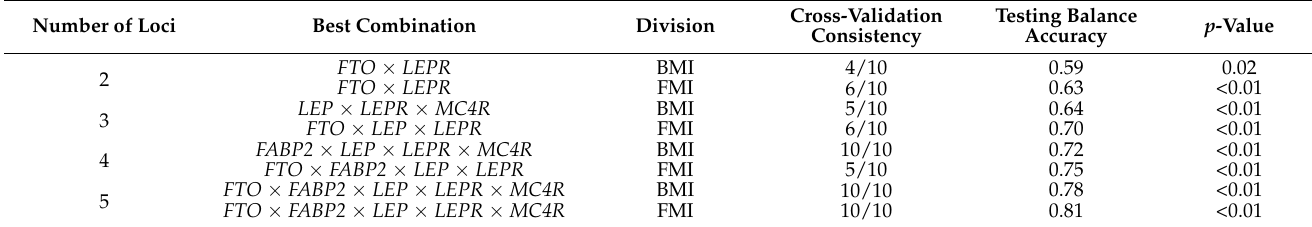
Table 7. Best gene–gene interaction models, as identified by